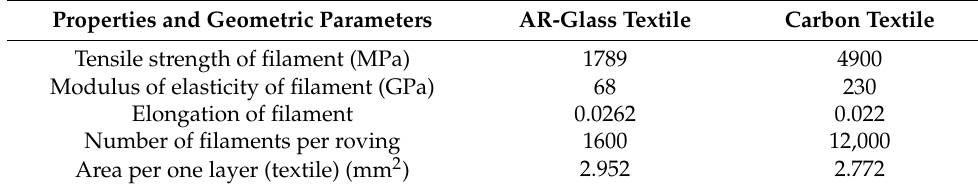
Table 1. Detailed specification of the AR-glass and carbon textiles.